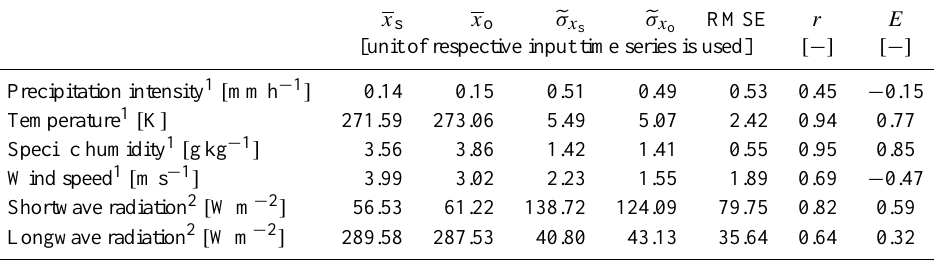
Table 6. Comparison of observed and simulated time series for the most relevant meteorological variables. This table includes simulated and observed mean of each variable for the winter season 2005–2006 ( x s and x o ), the corresponding standard deviation ( e σ x square error (RMSE), correlation ( r ), and the model efficiency ( E ). The superscripts denote the station for which the comparison was carried